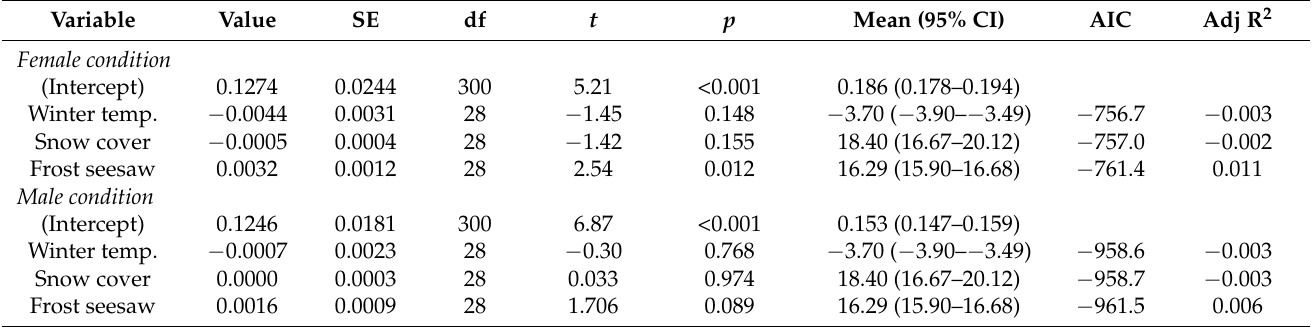
Table 2. Relationships between the winter weather variables examined and the body condition of female and male Tawny Owls Strix aluco near the southern coast of Finland: generalised linear models (glm). The parameter estimates of data (mean and 95% confidence interval) are given.